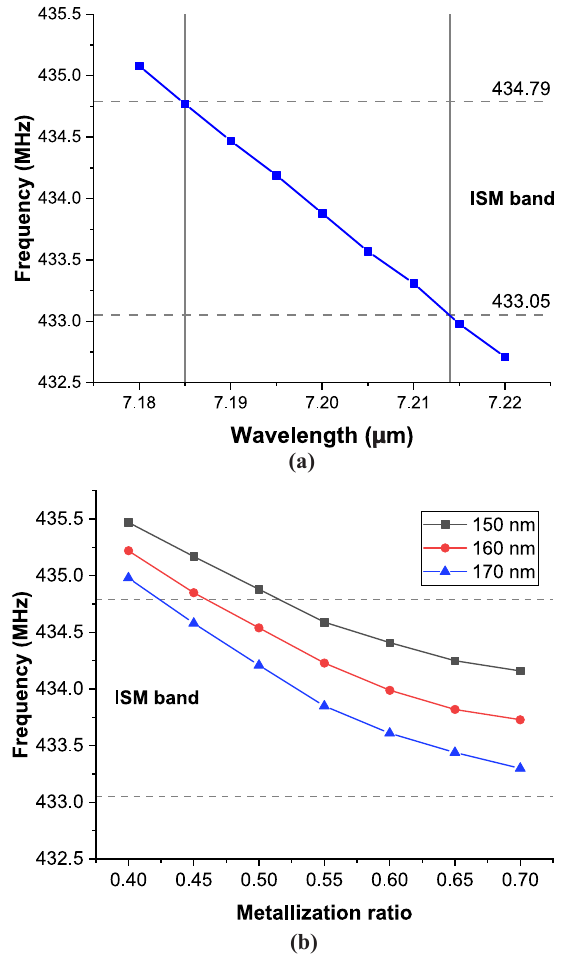
Figure 1. COMSOL Multiphysics simulation of lST-cut quartz SAW resonator 3D primitive cell. ( a ) Eigenfrequency vs. Interdigittated transducer wavelength at 160 nm Al metal thickness and 0.667 metallization ratio and ( b ) eigenfrequency vs. metal thickness for three different metal thicknesses and 7.2 µ m